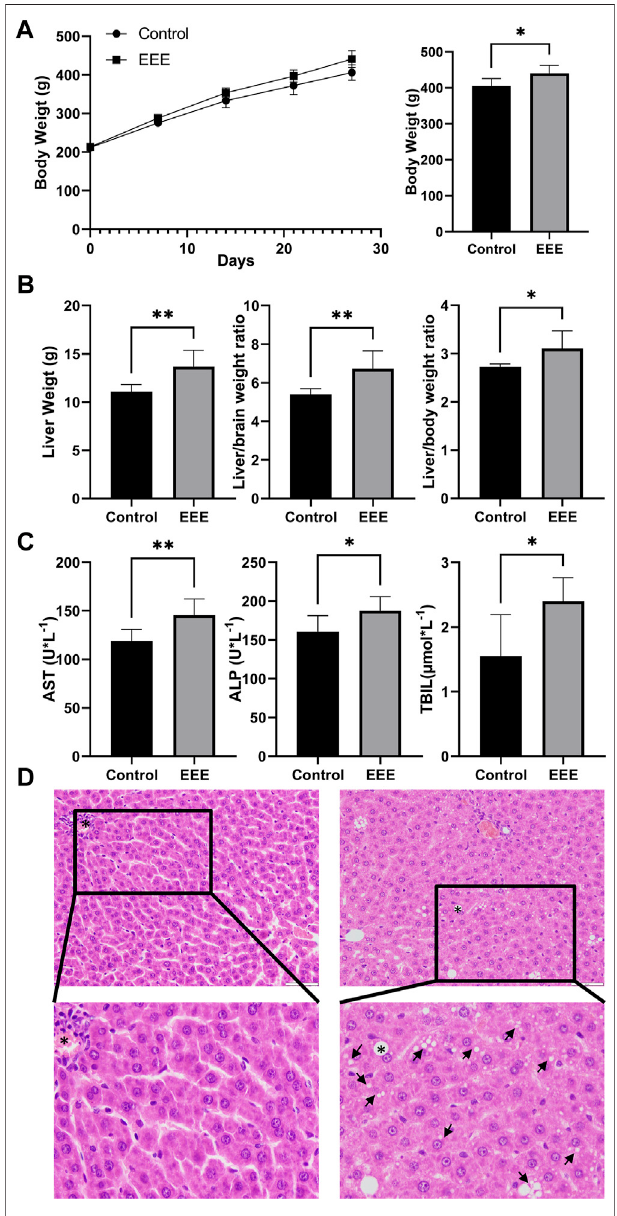
FIGURE 2 | The phenotype of EEE-induced liver injury in rats. (A) The EEE-induced phenotype of rat liver injury. The rats were randomly divided into the following two groups: a normal control group of rats (Control); a group of rats exposed to EEE (EEE). Results are presented as mean ± SD in rats, and signi fi cant differences are indicated ( p P < 0.05, pp P ≤ 0.01 vs. Control group, n = 6). (A) Bodyweight of rats during EEE exposure. (B) liver weight, liver/brain weight ratio, and liver/body weight ratio after 28 days of exposure. (C) Serum levels of AST, ALP, and TBIL were determined after 28 days of exposure. (D) Histopathological damage of rat liver was assessed by HE staining (H&E staining, ×200 magni fi cation).